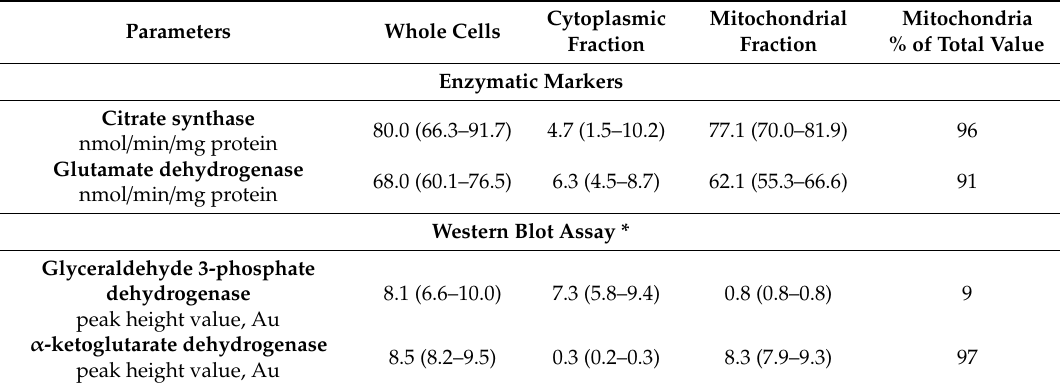
Table 3. Characterization of subcellular fractions isolated from SN56 cells (chronic experiments).